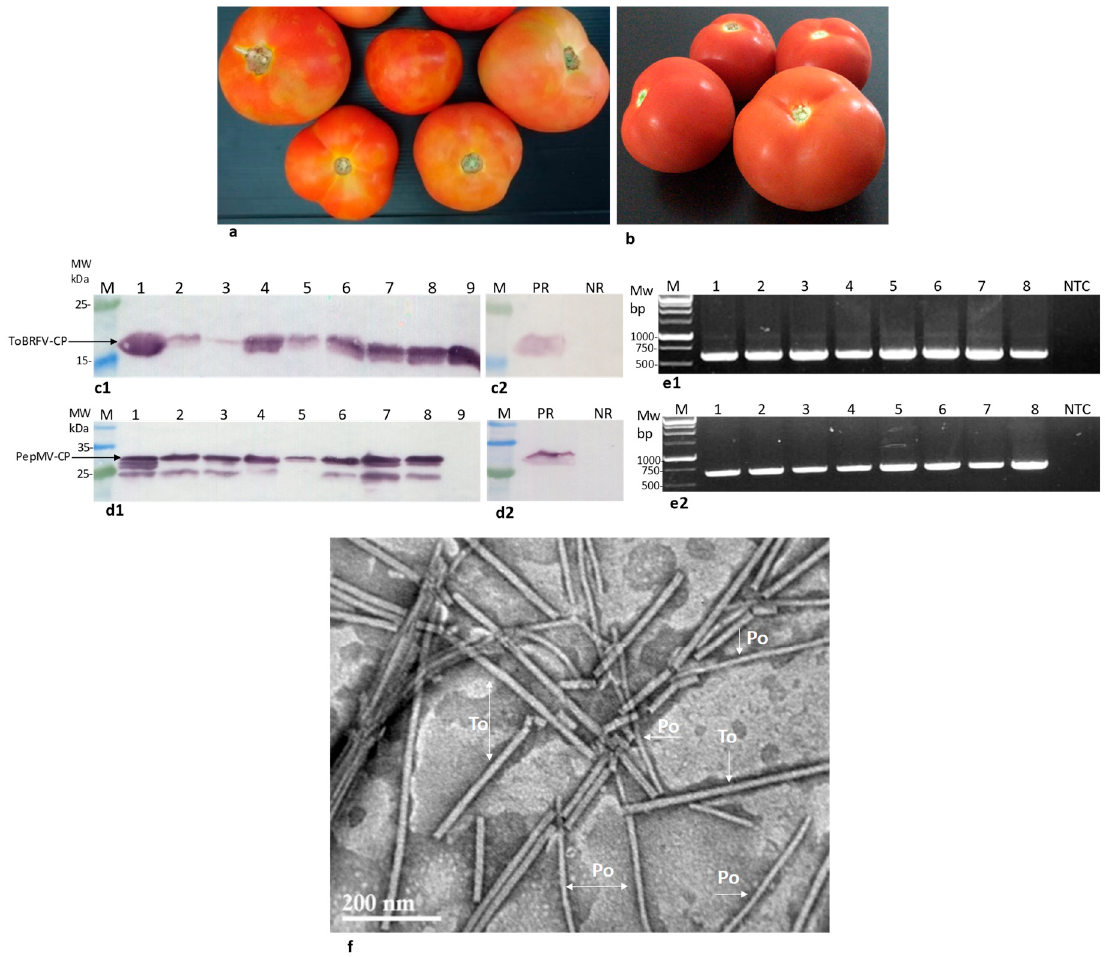
Figure 1. Symptomatic traded tomatoes were co-infected by tomato brown rugose fruit virus (ToBRFV) and pepino mosaic virus (PepMV). ( a ) Symptomatic tomatoes showing bleaching and marbled yellow spot phenotypes; ( b ) Asymptomatic tomatoes; ( c , d ) Western blot analyses of symptomatic tomatoes; ( c1 ) ToBRFV coat protein (CP) detection in symptomatic fruits; ( c2 ) CP detection in ToBRFV-infected tomato leaves; ( d1 ) PepMV CP detection in symptomatic fruits. The extra low molecular weight bands detected by the antibodies are apparently degradation products, as compared with data presented in ( d2 ); ( d2 ) CP detection in PepMV-infected tomato leaves; ( e1 ) RT-PCR amplified 615 bp segments of ToBRFV CP in the western blot positive co-infected tomatoes; ( e2 ) RT-PCR amplified 650 bp segments of PepMV CP in the western blot positive co-infected tomatoes; ( f ) Transmission electron microscopy visualization of symptomatic fruit virion purification showing particle morphology resembling tobamovirus and potexvirus viral genera. M, molecular weight; PR, positive reference; NR, negative reference; NTC, non-template control; Po, potexvirus; To, tobamovirus; arrows mark specific viral particles.